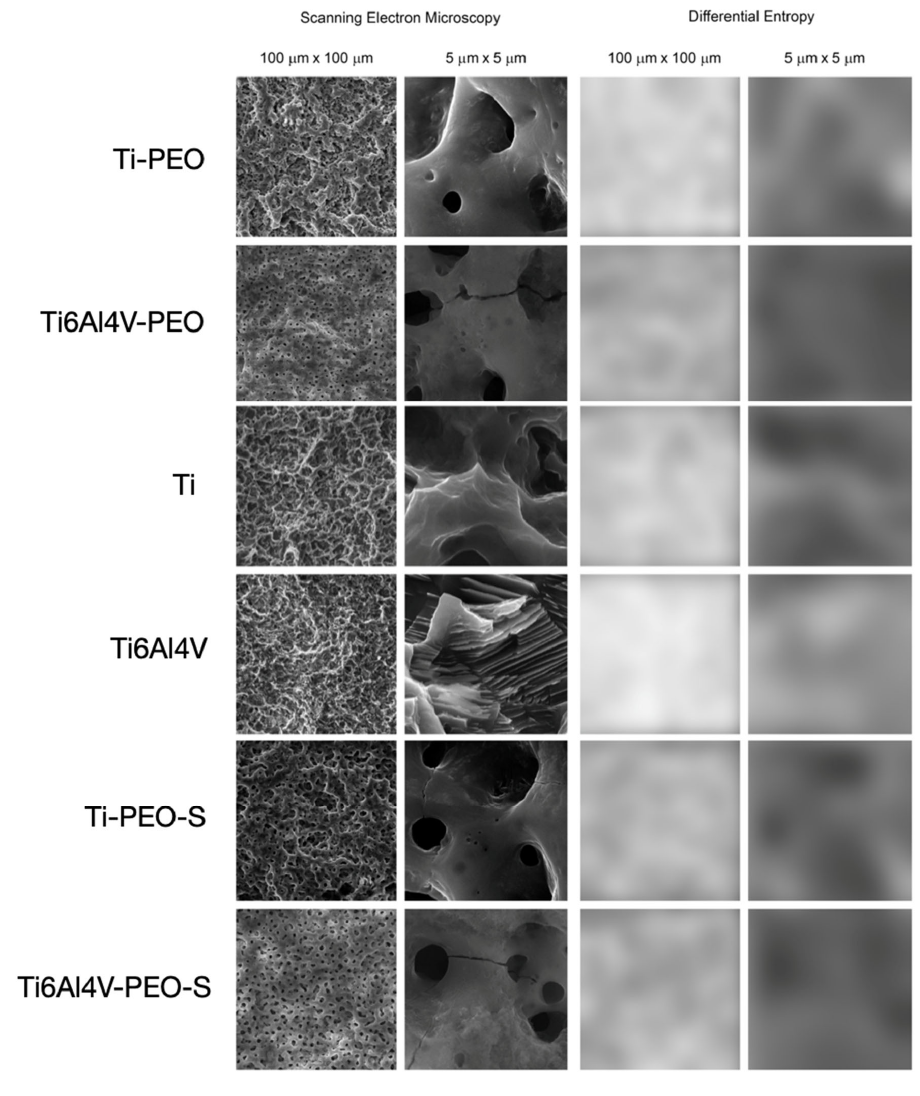
Figure 6. Texture analysis by means of calculation of differential entropy in SEM images on two scales. The two columns on the left show SEM images in the large (100 μ m × 100 μ m) and small field of view (5 μ m × 5 μ m). The two columns on the right represent intensity maps of the texture feature studied here in the original SEM image. The whiter areas indicate where the differential entropy is higher (i.e., the surface development is greater), while the darker areas indicate where the differen ‐ tial entropy is low (the implant surface image is more homogeneous). The differences between the tested surfaces are statistically significantly different from one another ( p < 0.05) in terms of differ ‐ ential entropy (both at low and high magnification).